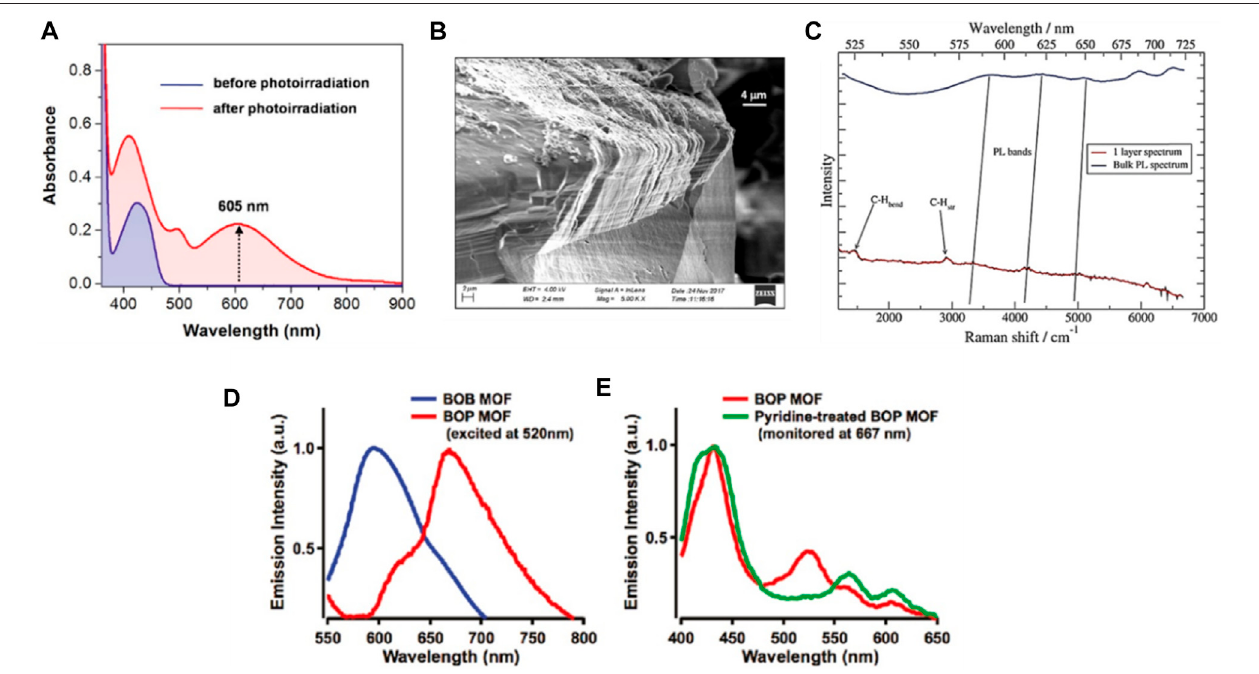
FIGURE 8 | (A) UV-visible absorption spectra of Cd-DP. (B) SEM images of Cd-DP [adapted and modi fi ed from (Mukhopadhyay et al., 2018)]. (C) Raman and photoluminescence spectra of [Cu( μ -pym 2 S 2 ) ( μ -Cl)]n nMeOH [adapted and modi fi ed from (Hermosa et al., 2015)]. (D) PL spectra of BOB and BOP MOFs and (E) PLE spectra of BOP and pyridine-treated BOP MOF [adapted and modi fi ed from (Lee et al., 2011)].